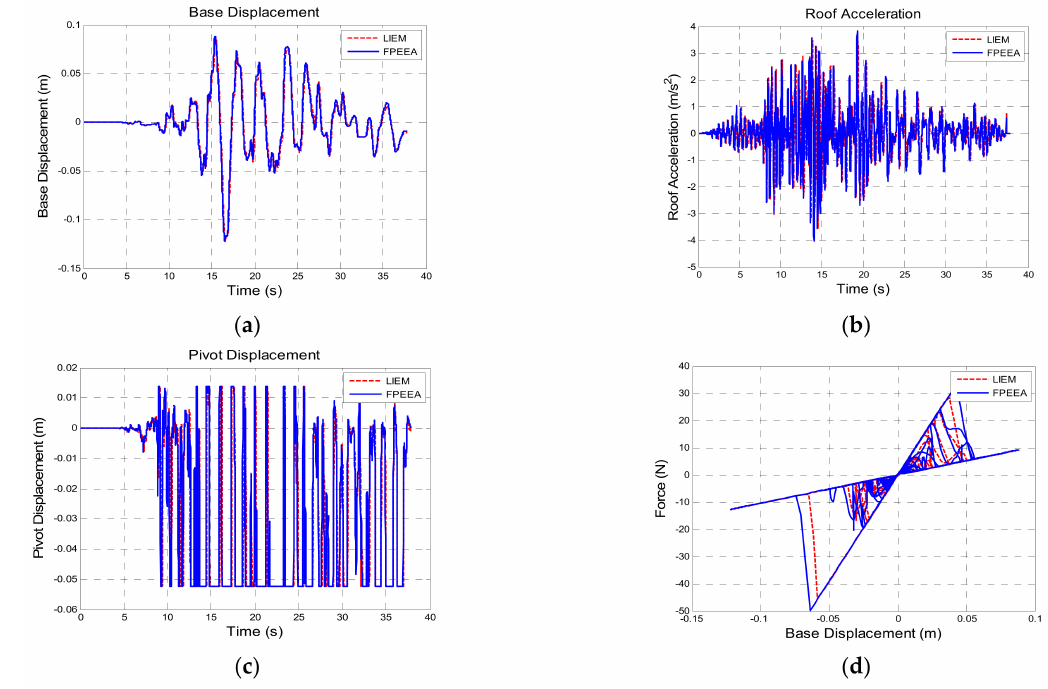
Figure 9. Comparison for the FPEEA and LIEM controls (Northridge, PGA = 0.3 g). ( a ) Isolation layer displacement.